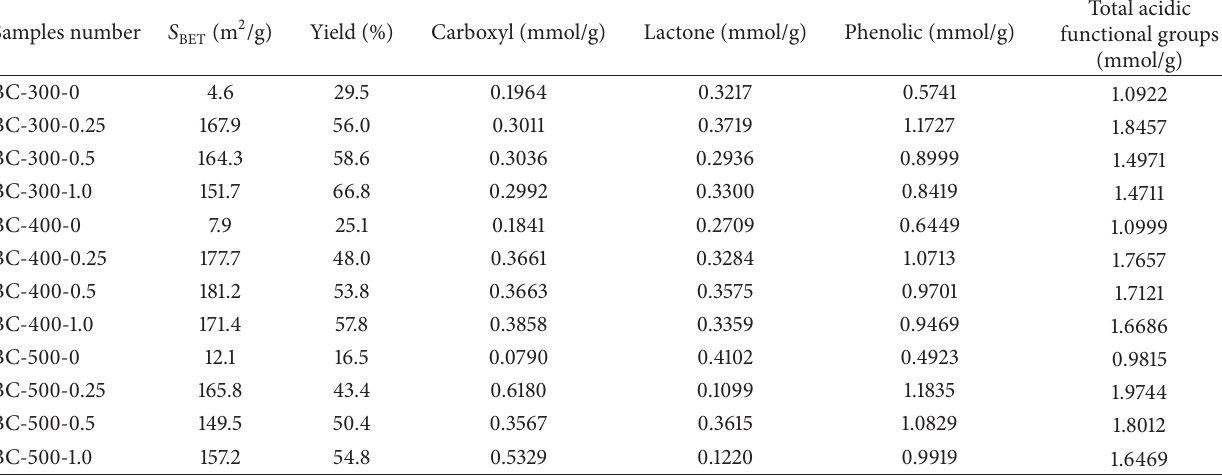
Table 1: Surface area, yields and surface functional groups of the BC